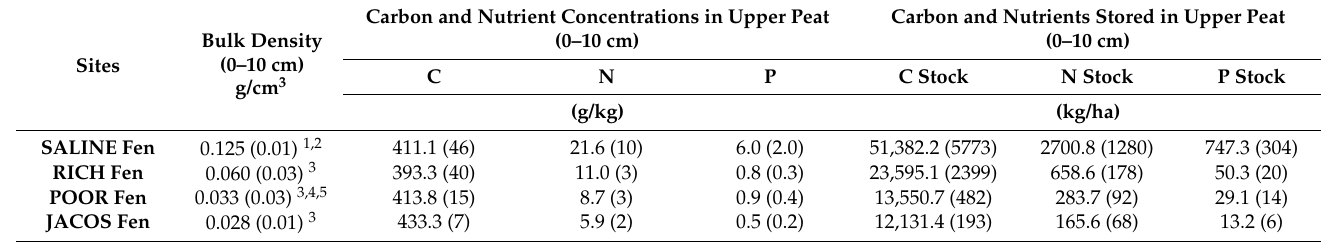
Table 4. Mean bulk density, carbon, and nutrients concentrations (standard deviation) used in estimating potential C and nutrients (N and P) stock among the range of peatland in the Athabasca Oil Sands Region.